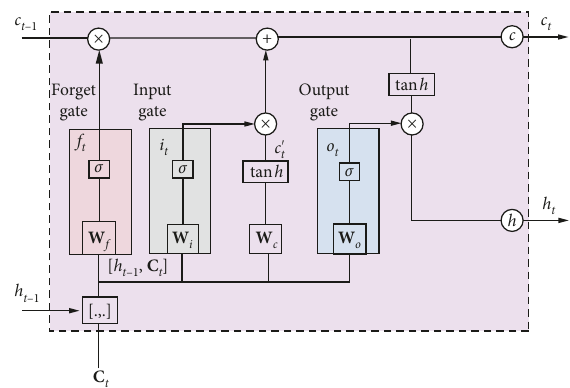
Figure 5: Long short-term memory (LSTM) module.